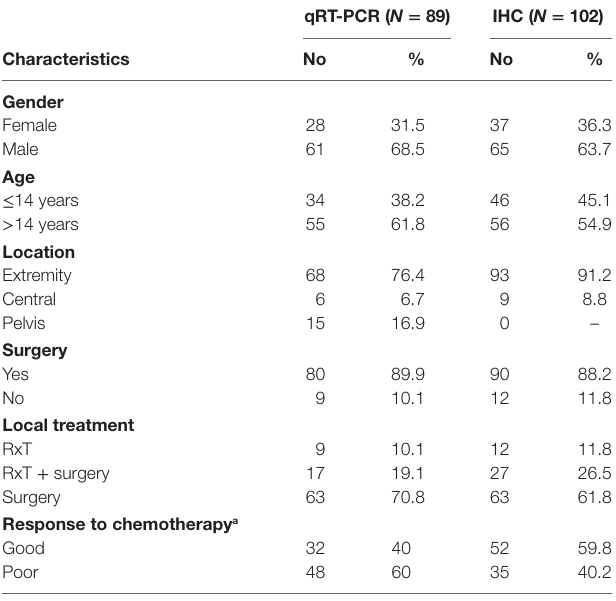
TaBle 1 | Clinico-pathological features of ES patients included in the